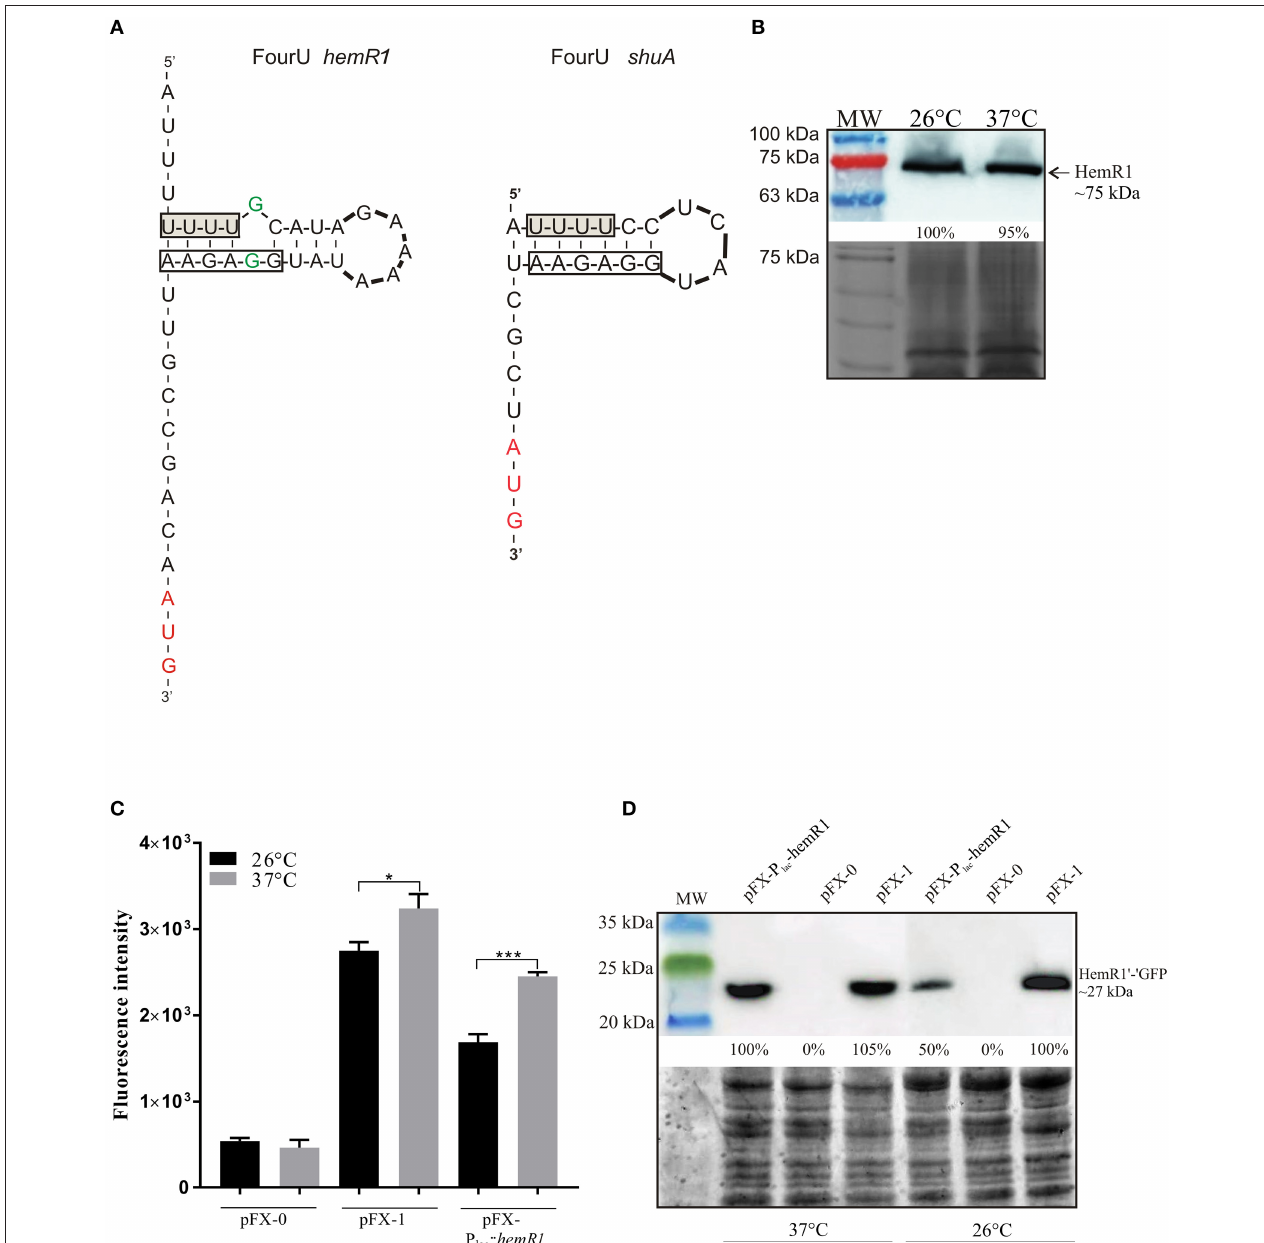
FIGURE 8 | Influence of temperature on hemR1 expression. (A) Potential FourU thermometer RNA secondary structures in the 5 ′ -UTRs of Y. enterocolitica Ye9 hemR1 and S. dysenteriae shuA , composed of a stretch of FourU and the ribosomal binding site (RBS), revealed by Mfold analysis (http://mfold.rna.albany.edu). Boxes indicate the location of the FourU motif (shaded) and putative RBS, the translation start codon is marked red, and unpaired nucleotides within the predicted secondary structure are in green. (B) Temperature-dependent HemR1 expression in Y. enterocolitica examined by immunoblotting. The analyzed samples were cell lysates of the fur mutant grown at 26 or 37 ◦ C in LB medium. The top panel shows the Western blot probed with a polyclonal antibody against HemR1, the bottom panel shows the Coomassie blue-stained gel as a loading control. The percentage values on the blot, indicating the HemR1 band intensities relative to that of cells grown at 26 ◦ C, were determined using Amersham Imager 600 Analysis Software V1.0.0 (GE Healthcare). (C) Expression of a hemR1 ′ - ′ gfp translational fusion at different temperatures, monitored by fluorescence intensity. E. coli BW25113 harboring the reporter plasmid pFX-P lac -hemR1 or control plasmids pFX-0 and pFX-1 were grown in LB medium at 26 or 37 ◦ C. The GFP fluorescence intensity (RFU) of overnight cultures was determined. The data represent the averages ± SD from at least three experiments with duplicate cultures. Significance was calculated using one-way ANOVA [ P > 0.05, * P < 0.05, *** P < 0.001]. (D) GFP abundance examined by immunoblotting. The analyzed samples were cell lysates of E. coli BW25113 harboring the plasmids pFX-0, pFX-1 or pFX-P lac -hemR1. The top panel shows the immunoblot probed with antibody against GFP, the bottom panel shows the TGX Stain-Free gel as a loading control. MW, 3-Color Prestained Protein Marker; kDa. These results are representative of at least three independent